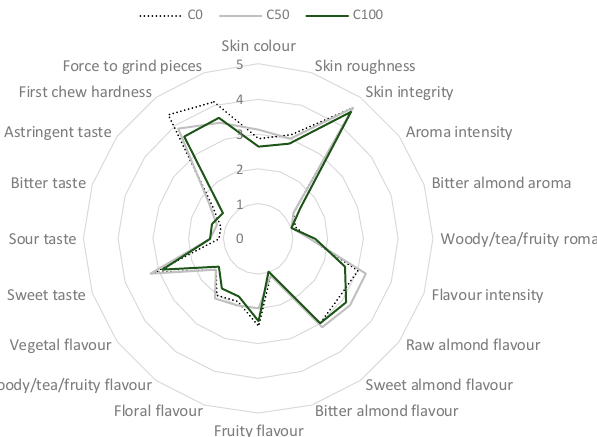
Figure 4. Spider plot of the sensory profile almond kernels with or without the application of biostimulants. C0—control treatment with water; C50, Superfifty at 0.5 L/ha; C100, Superfifty at 1 L/ha.